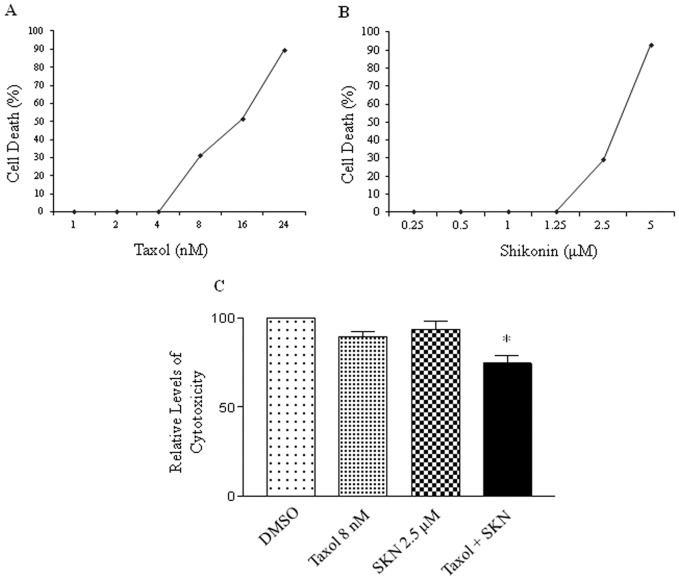
Cytotoxicity assay of the combination treatment.MTT assays were performed to select the concentrations of taxol (A) and shikonin (B). C, cytotoxicity measurement of the combination of taxol and shikonin. The experiments have been repeated more than three times. * p<0.05 when compared to the control (DMSO).